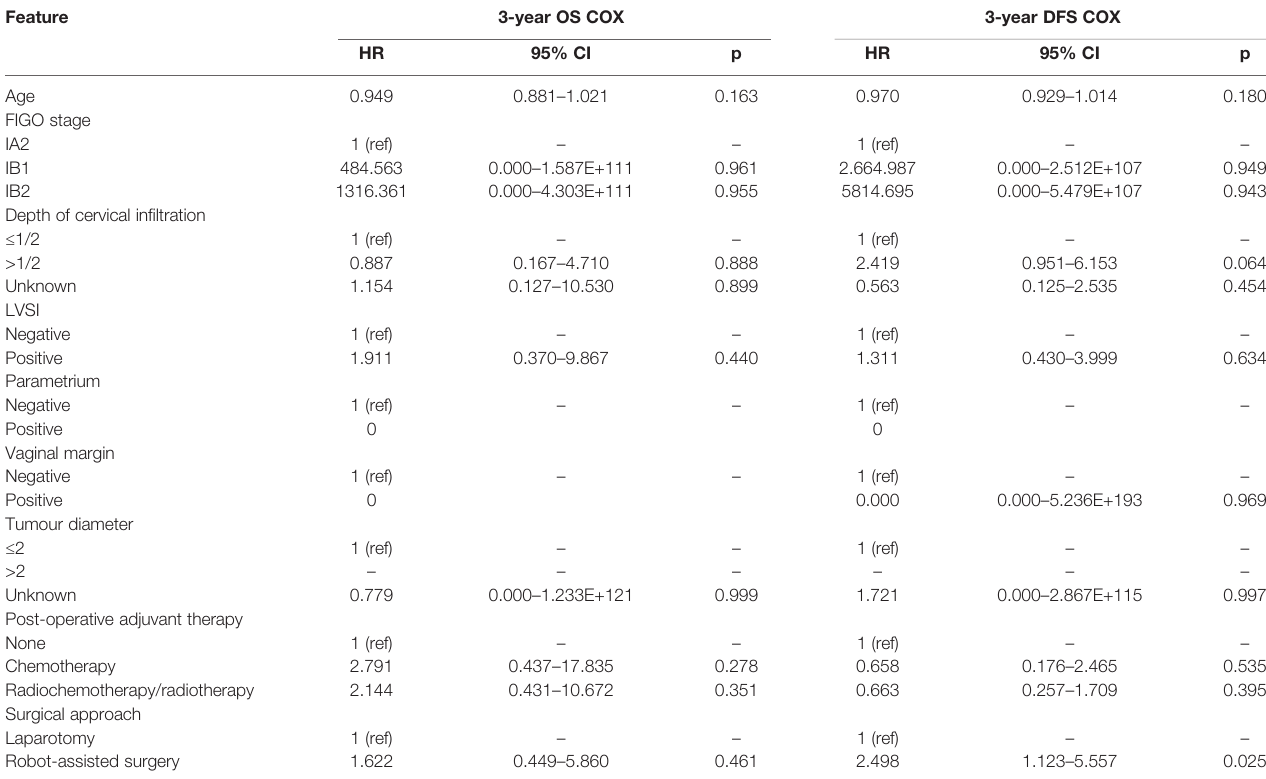
TABLE 3 | Cox multivariate analysis of the relationship between surgical approach and OS and DFS in cervical cancer after PSM.